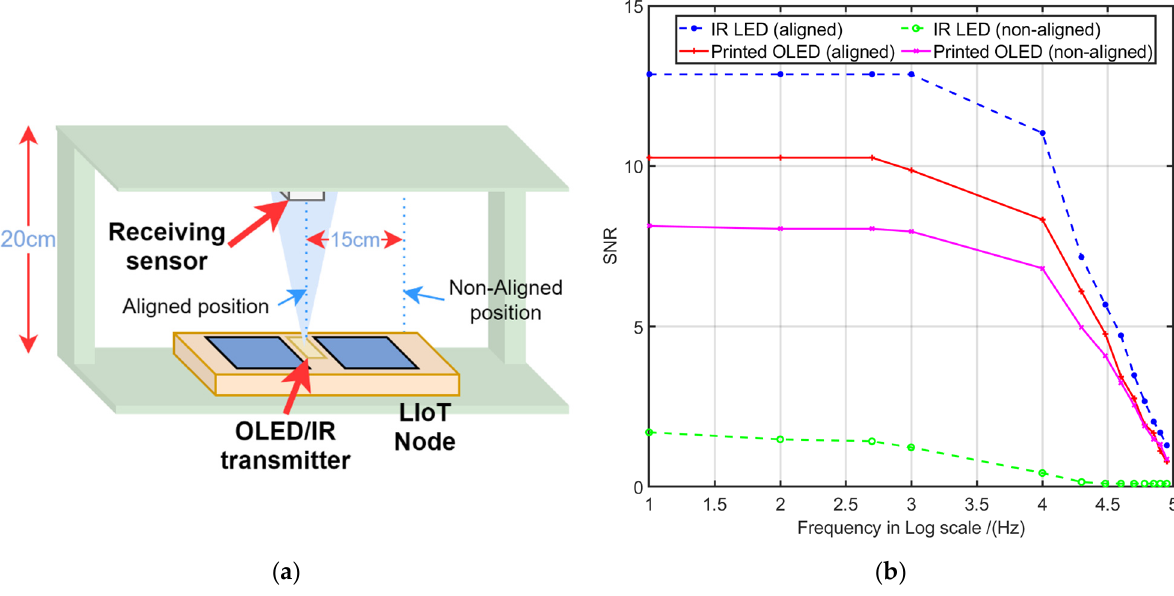
Figure 12. ( a ) Experiment setup arrangement; ( b ) IR vs. printed OLED under different link alignments.